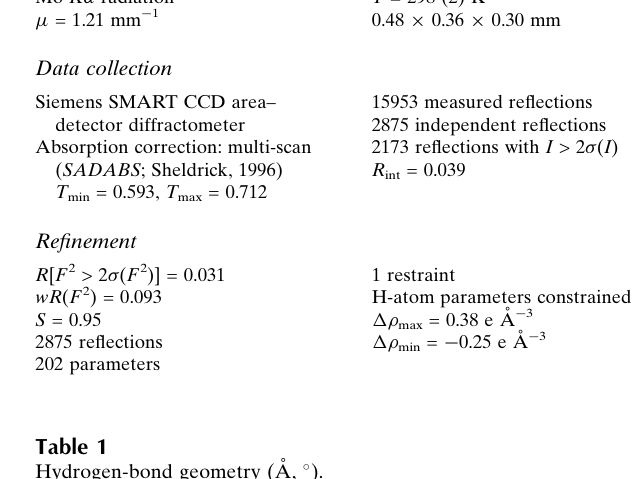
Hydrogen-bond geometry (A˚ , (cid:4)